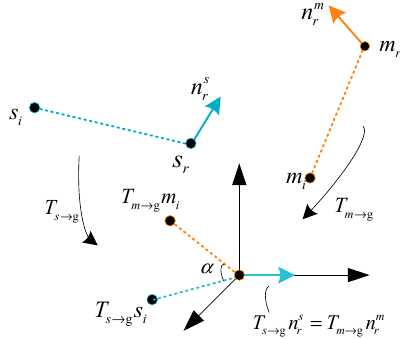
Figure 9. Model and scene coordinate system transformation.